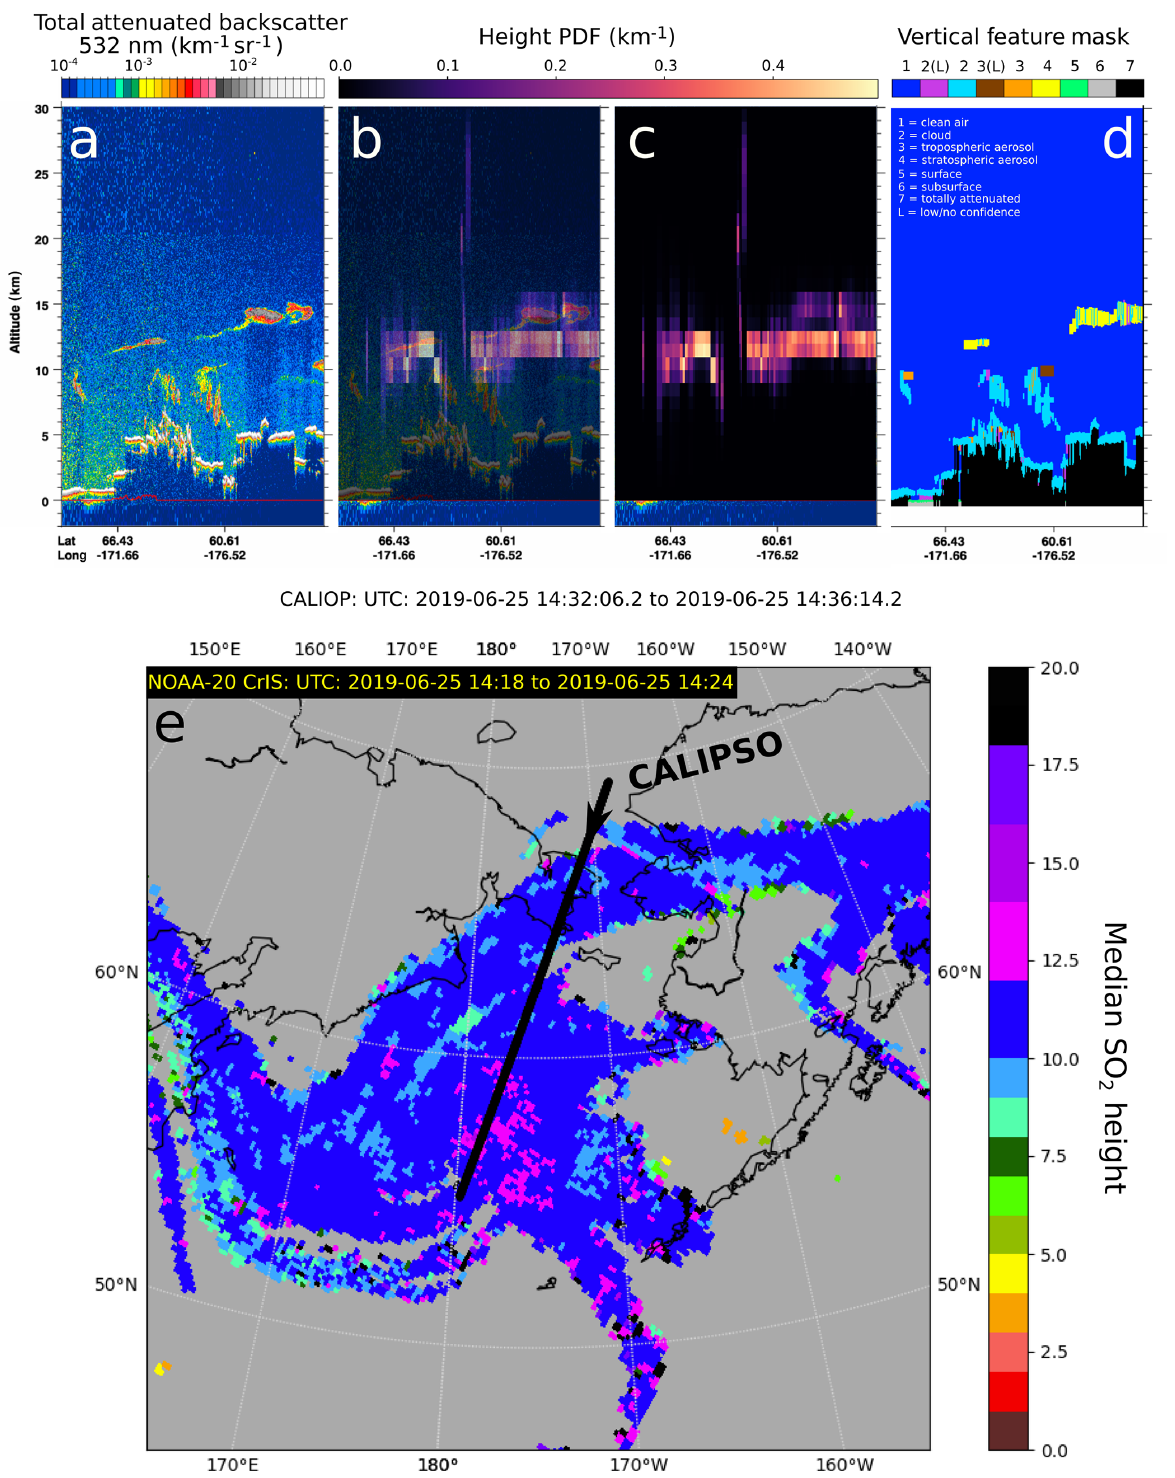
Figure 11. Representative example comparison of CALIOP lidar backscatter (a, b) , CrIS SO 2 height PDFs ( b partially transparent, c ), and CALIOP vertical feature mask (d) for the Raikoke cloud on 25 June 2019. (e) Nearest-neighbor gridded interpolation of CrIS SO 2 median heights with the closest CALIOP overpass shown (black arrow indicating descending orbit < 15min after CrIS